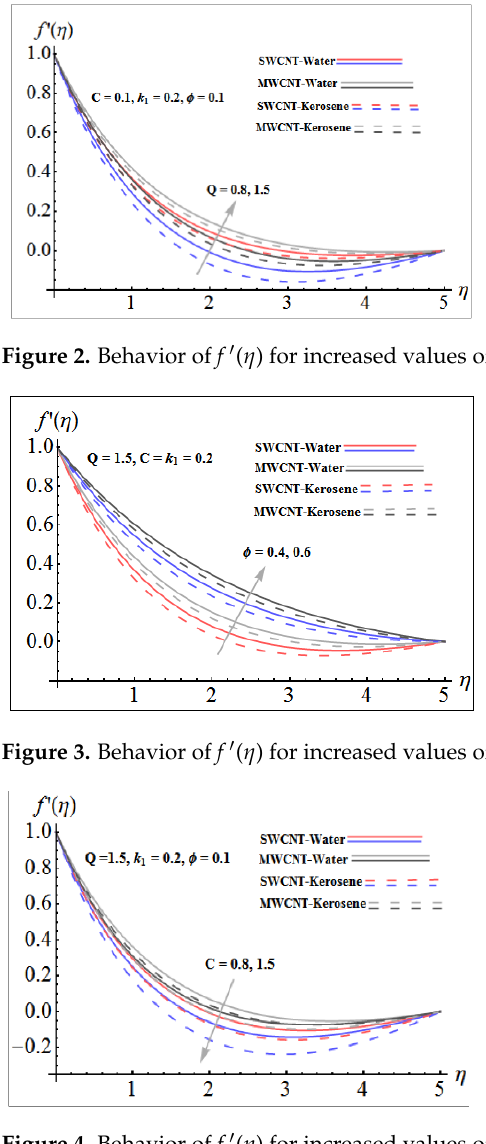
Figure 5. Behavior of f ′ ( η ) for increased values of 𝑘 (cid:2869) .